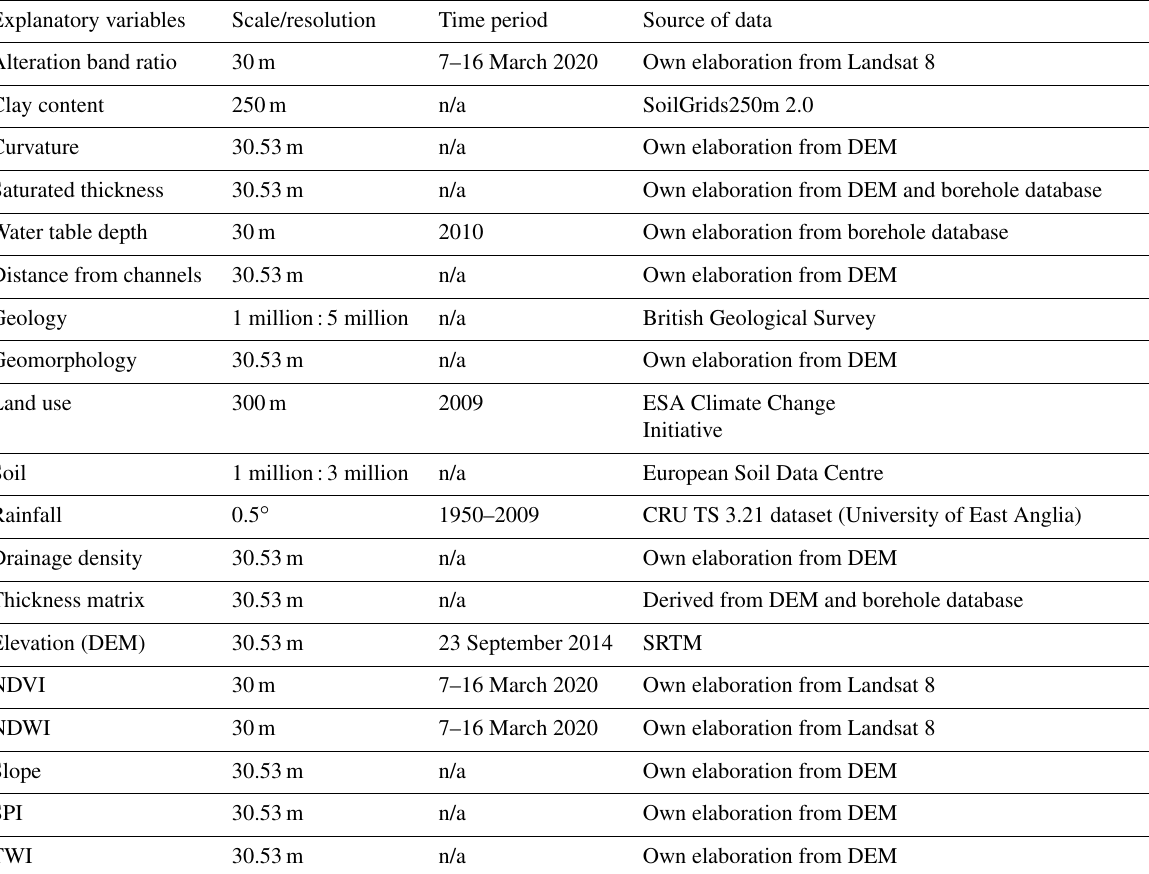
The abbreviations used in the table are as follows: DEM – digital elevation model; NDVI – normalized difference vegetation index; NDWI – normalized difference water index; SPI – stream power index; TWI – topographic wetness index; ESA – European Space Agency; CRU TS – Climatic Research Unit (CRU) Time Series (TS); SRTM – Shuttle Radar Topography Mission; n/a – not